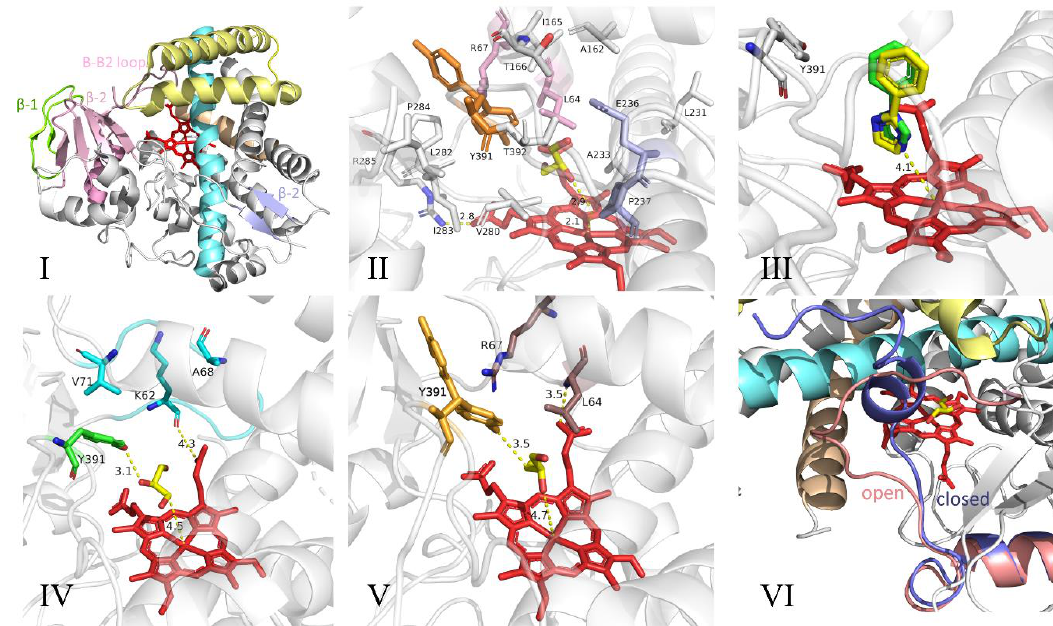
Figure 7. Structure and analysis of CYP134A1 A356T [3]. ( I ) The overall structure of CYP134A1 A356T (most of CYP134A1 are shown in gray, some structural motifs are colored; heme is shown in red), and the structural motifs are marked [3]. ( II ) The closed configuration of the B-B2 loop, which indicated that the active site is highly hydrophobic (B-B2 loop residues shown in pink participate in the formation of the active site pocket, and the two conformations of Tyr391 are shown in orange) [3]. ( III ) Structure of CYP134A1 A356T bound to phenyl imidazole ligand (1-phenylimidazole is shown as a green rod, 2-phenylimidazole is shown as a limon rod) [3]. ( IV , V ) Effects of the alternate B-B2 loop conformations on the active site pocket (open B-B2 loop and residues that form the active site shown in aquamarine, closed B-B2 loop residues that form the active site shown in darksalmon,Tyr-391 conformations shown in green for the open B-B2 loop and in bright orange for the closed B-B2 loop); for all, hydrogen-bonding distances indicated by yellow dashed lines, heme shown in red, majority of CYP134A1 shown in gray [3]. ( VI ) Alternative conformation of B-B2 ring (most CYP134A1 is shown in gray, B-B2 ring is shown in slate as closed form and salmon as open form; heme is shown in red), with selected structure Motif mark [3].